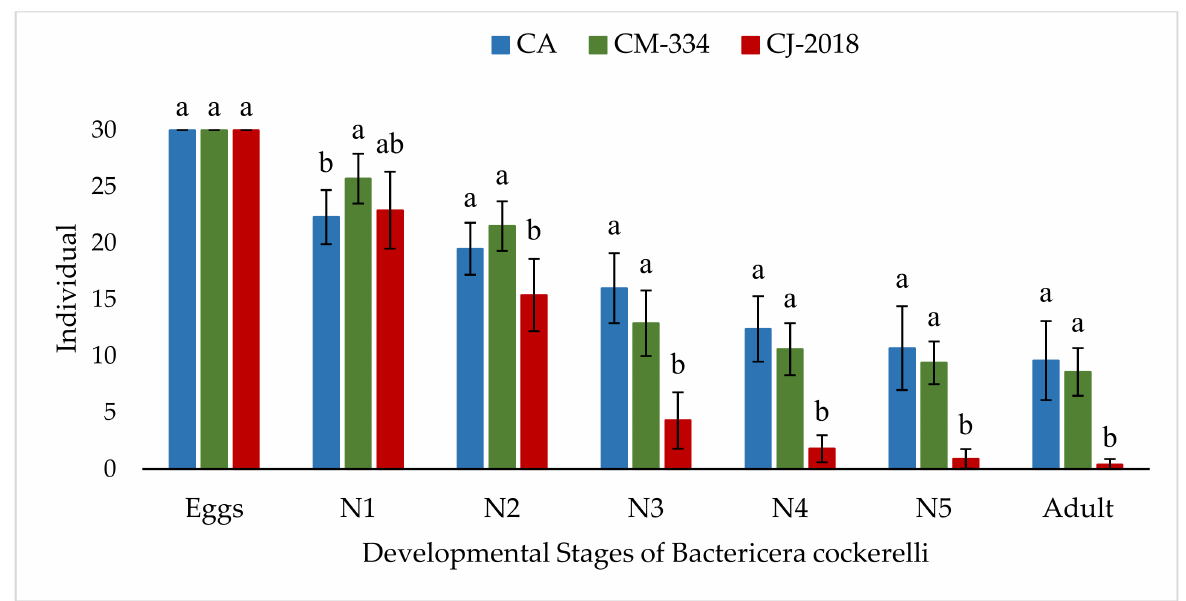
Figure 2. Development of Bactericera cockerelli fed with chili plants of the ‘Arbol’ variety (CA), ‘Criollo de Morelos’ (CM-334), or ‘Criollo de Jojutla’ (CJ-2018). N1: First instar nymph, N2: Second instar nymph, N3: Third instar nymph, N4: Fourth instar nymph, N5: Fifth instar nymph. Each point represents the average of 10 repetitions with 30 individuals each. Values with different letters in each developmental stage are significantly different (Tukey test p <